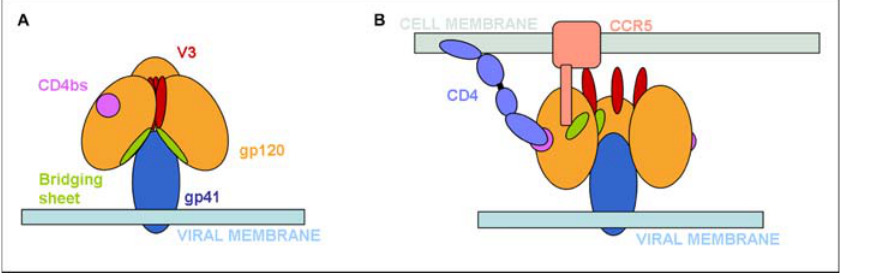
Figure 4. Model for HIV/SIV Receptor Engagement, Based on the First Proposed Fitting (A) The Env complex before CD4 binding. The bridging sheet is not accessible to co-receptor and antibodies, and the V3 loop is at the trimer interface. (B) CD4 binding causes a conformational change and an overall rotation of the gp120 molecule. The V3 loop binds selectively to co-receptor, and the bridging sheet becomes exposed and available for co-receptor binding. DOI: 10.1371/journal.ppat.0020083.g004